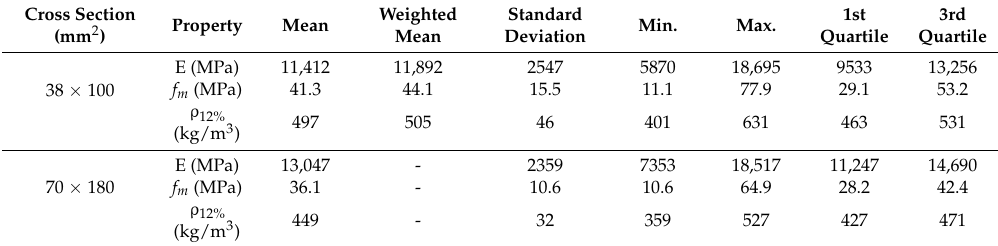
Table 3. Physical and mechanical properties measured on the 445 38 × 100 mm 2 and 261 70 × 180 mm 2 boards studied. The averages for the lowest cross section (38 × 100 mm 2 ) were calculated on the basis of both the raw values (i.e. , not weighted according to the radial position of the boards) and the weighted values; the values for the largest cross section (70 × 180 mm 2 ) did not require